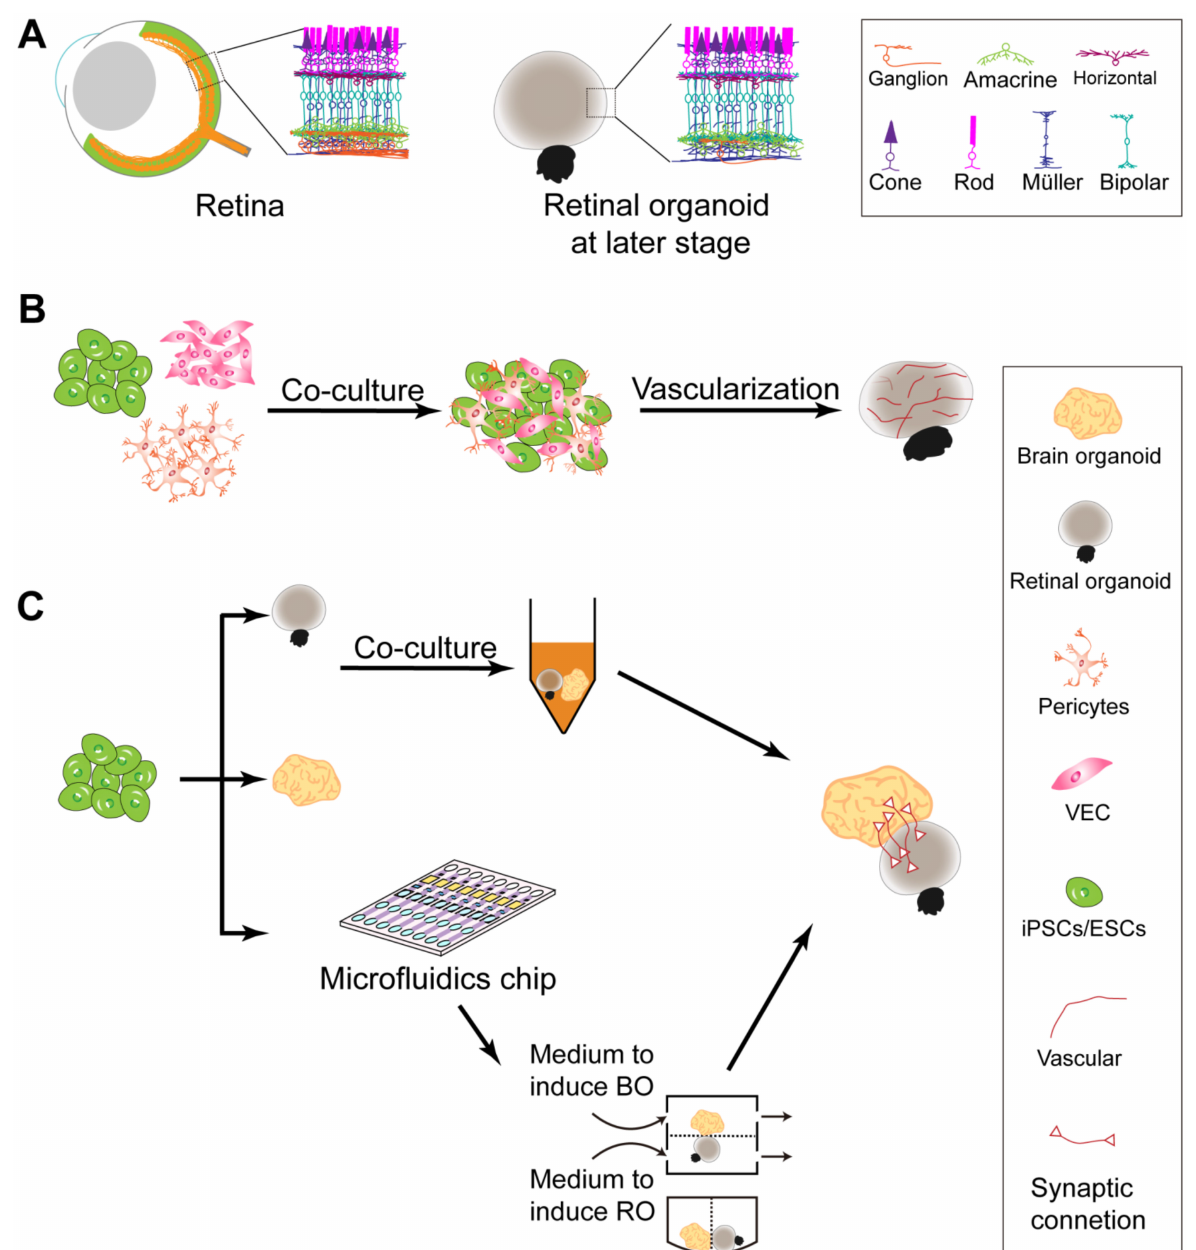
Figure 2. Strategies to retain the inner cell layers of retinal organoids. ( A ) Unlike native retinas, the inner cell layers of retinal organoids, which contain RGCs, amacrine cells, horizontal cells, and Müller cells, tend to degenerate during culture. ( B ) Reasons for the degeneration of inner cell layers include hypoxia and/or malnutrition. To solve the problem, iPSCs or ESCs may be reaggregated with vascular endothelial cells to form vascularized retinal organoids. More oxygen and nutrients diffuse into inner layers through blood-vessel-like tunnels and help the cells of the inner layers, especially RGCs, to survive longer. ( C ) Another reason for inner cell degeneration is the loss of synaptic connections to the brain. To establish the connections, brain and retinal organoids of the proper developmental stage may be co-cultured in a single 96-well. Alternatively, retinal and brain organoids are cultured in separate chambers but connected through channels in the microfluidic chip. Synaptic connections may be established to communicate retinal with brain organoids. BO, brain organoid; RO, retinal organoid; VEC, vascular endothelial